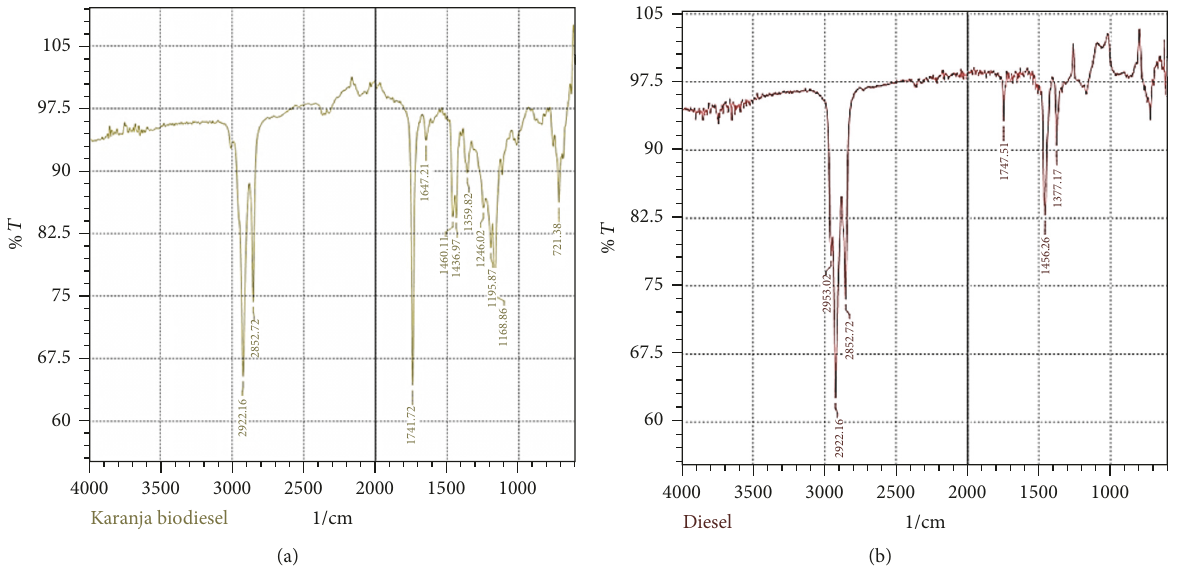
Figure 8: FTIR spectrum of (a) karanja biodiesel and (b) conventional diesel.